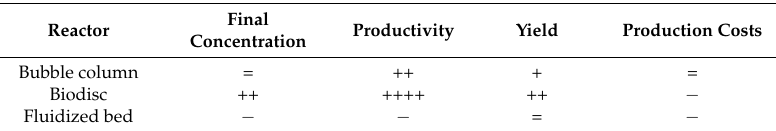
Table 4. Reactors for fumaric acid bio-production as compared to the classical batch reactor: strengths and